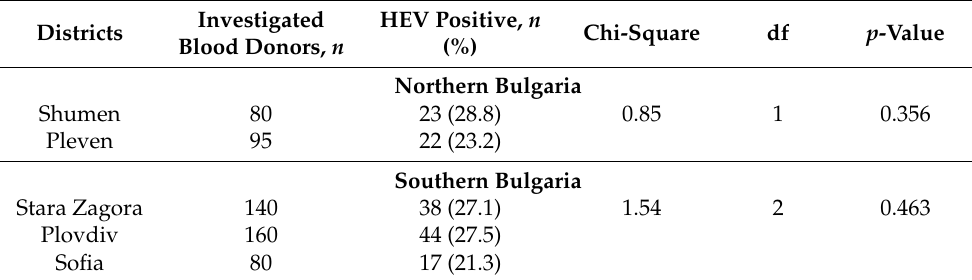
Table 2. Seroprevalence of HEV infection by district in blood donors from Bulgaria.